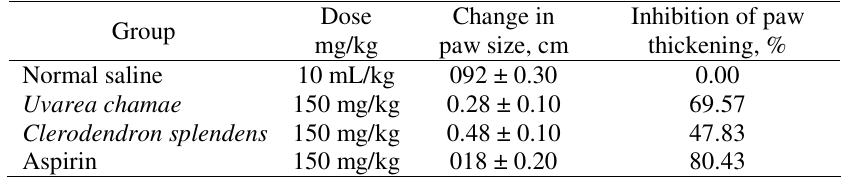
Table 2. Effects of crude extracts of Uvarea chamae roots and Clerodendron splendens leaf and aspirin on carrageenan induced paw oedema